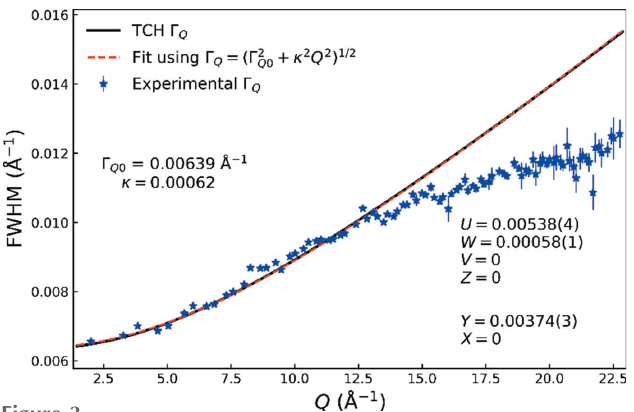
Figure 3 FWHM of Si at 100 K. The blue stars show experimental FWHM from single-peak fitting using a generic pseudo-Voigt function. The black line shows the FWHM function obtained from the refined TCH parameters in Rietveld analysis of the Si 300 K data. The red dashed line shows a least- squares fit to the TCH FHWM using the function (cid:4) The refined values of (cid:4) Q 0 and (cid:6) are shown alongside the refined TCH peak-profile parameters U , V , W , Z , X and Y